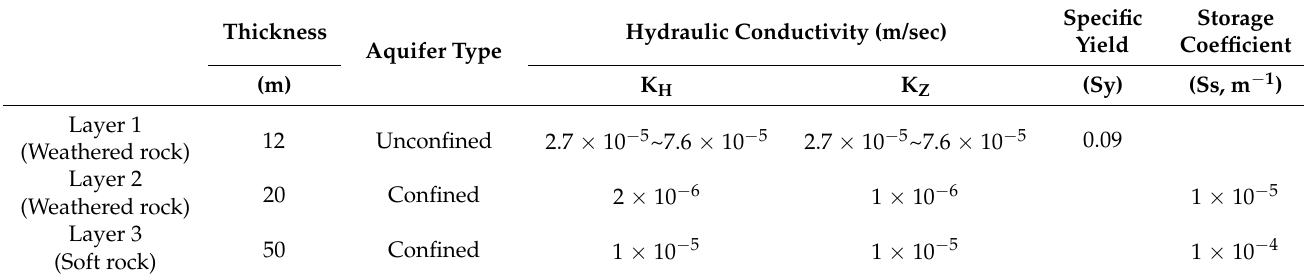
Figure 4. Model grids and the boundary conditions of the study site. Table 1. MODFLOW input data for layer properties (modified from Chang and Chung